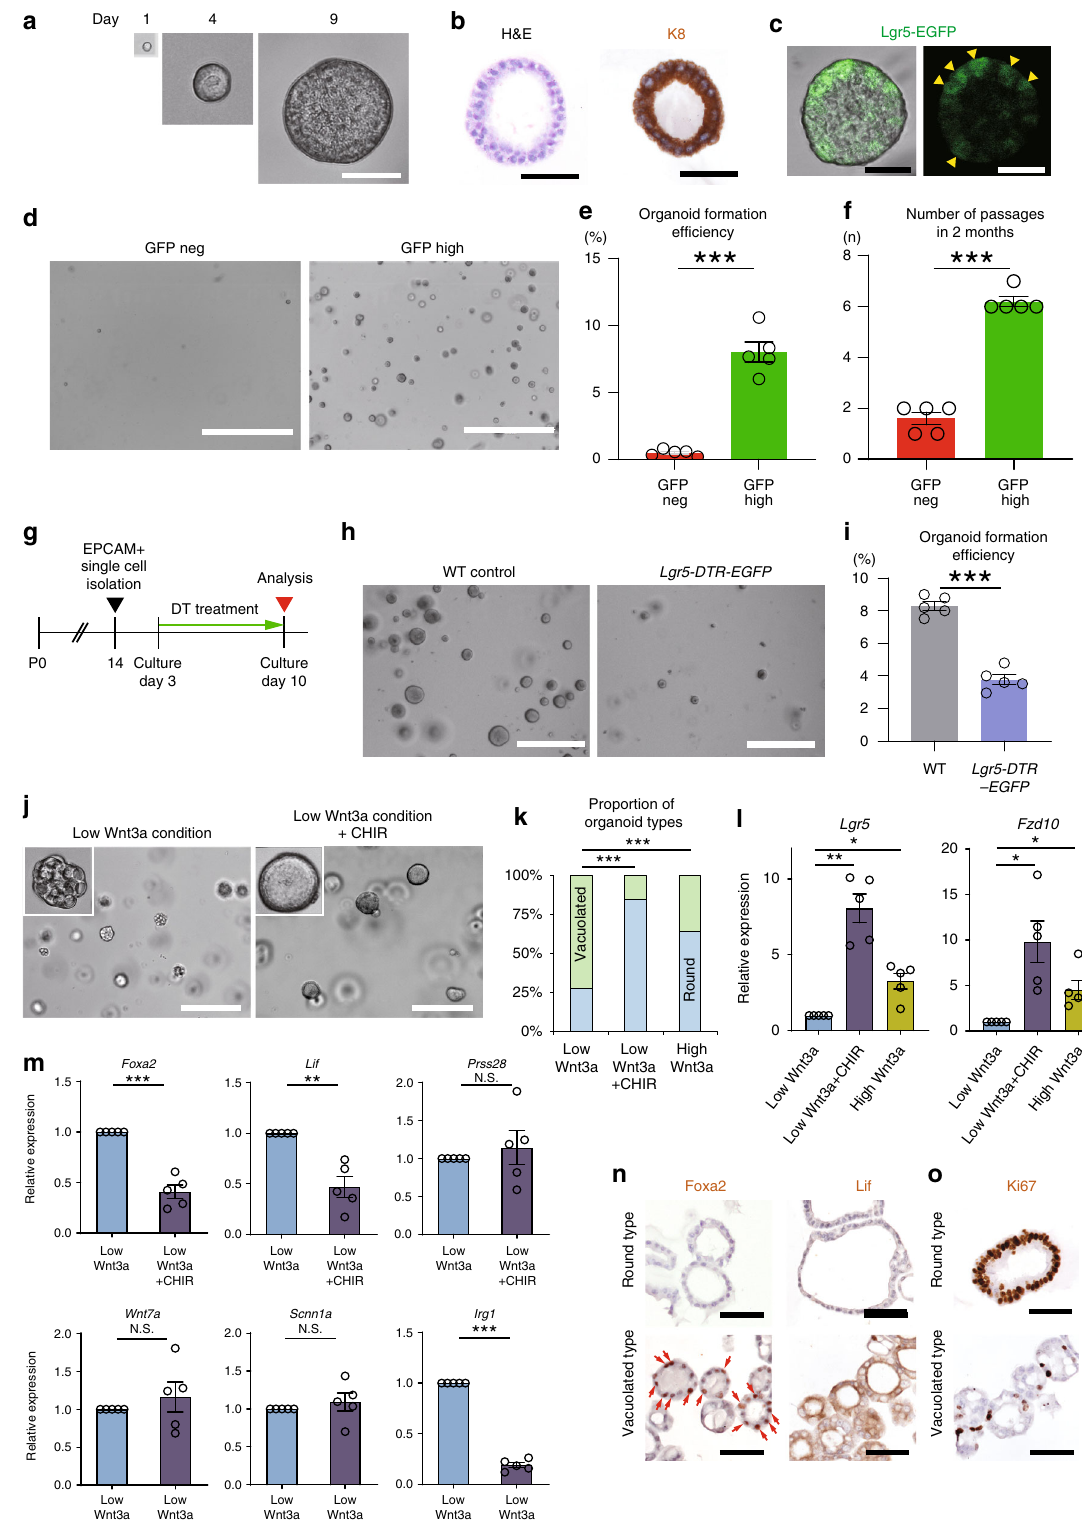
been identi fi ed as an epithelial Wnt source for Lgr5 + stem cells in the intestine 42 . In future, it will be interesting to investigate the potential existence of functional redundancy between the epi- thelial and stromal Wnt sources in the developing uterus. Progesterone is known to suppress endometrial development 34 . We show Lgr5 expression is down-regulated in